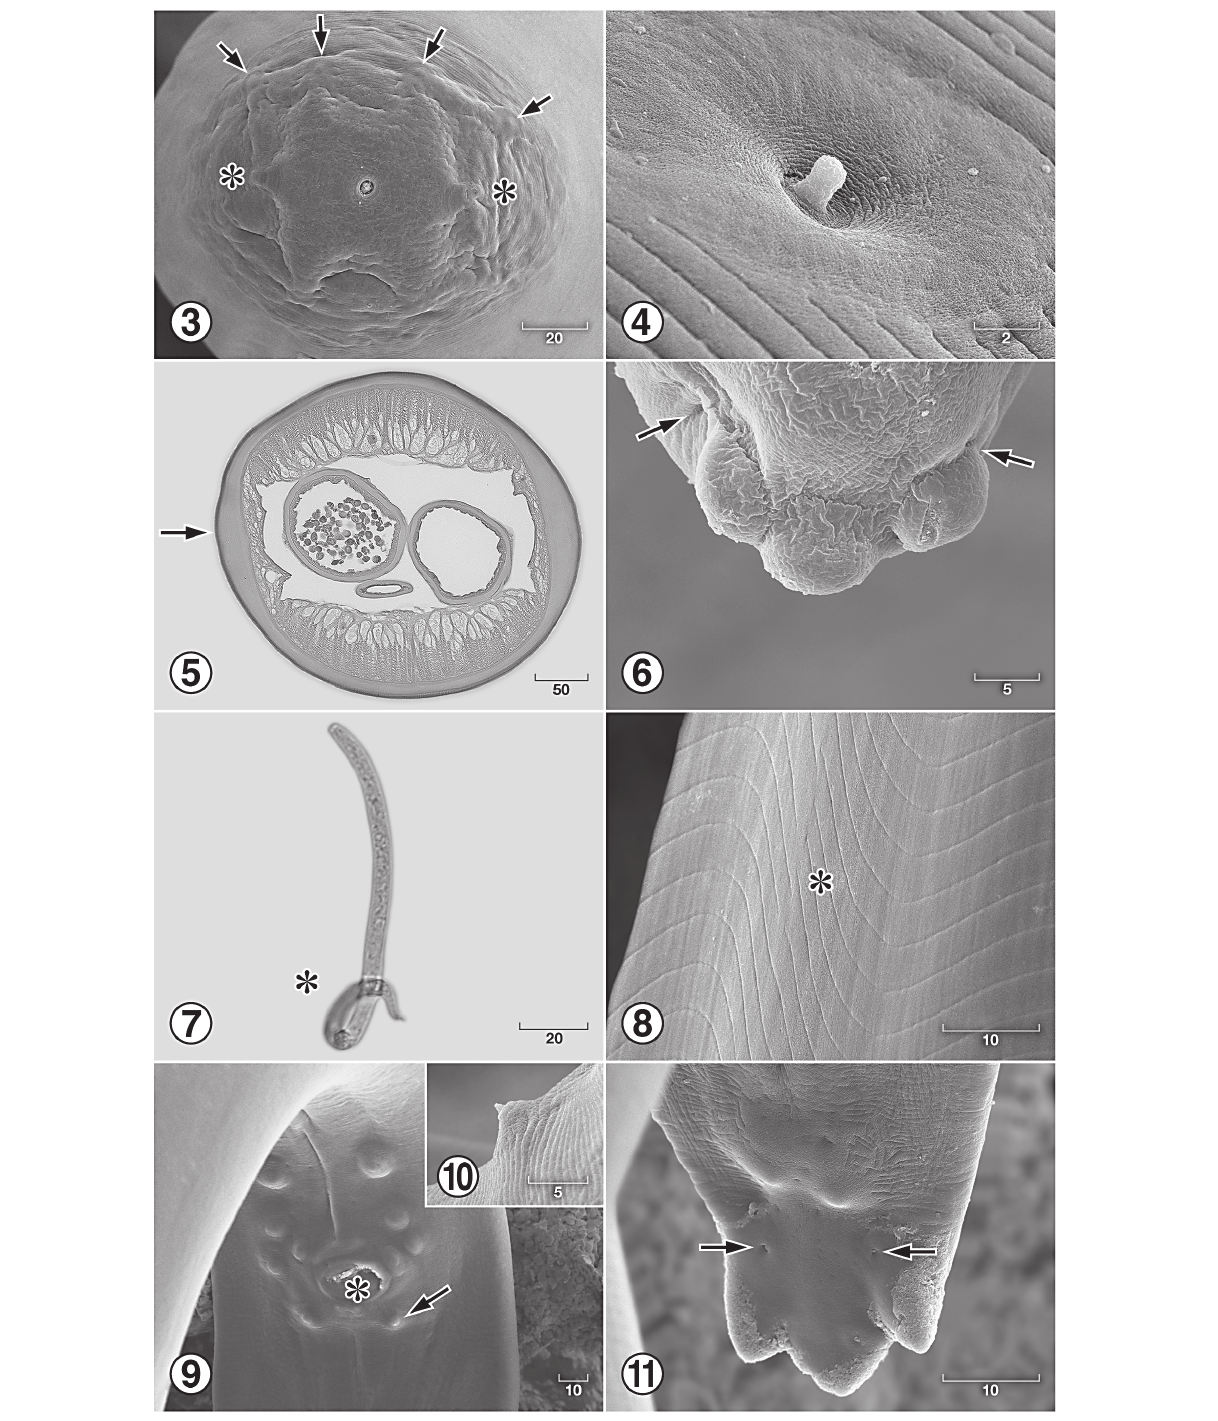
Fig. 5. – Transverse section of a female L. caprini n. sp. Lateral thickening of the cuticle (arrow). Bar, micrometers. Fig. 6. – SEM of posterior end of a female L. caprini n. sp. with phasmidial pores (arrows) and three round lappets. Bar, micrometers. Fig. 7. – Microfilaria taken from ovejector of a female L. caprini n. sp. seen by differential interference contrast microscopy. Coiled pos- terior end (*). Bar, micrometers. Fig. 8. – Oblique striations (*) in the lateral field of the midbody of a male L. caprini n. sp. Bar, micrometers. Fig. 9. – SEM of papillae around the cloaca (*) in a male L. caprini n. sp. Pair (no. 6) of papillae (arrow). Bar, micrometers. Fig. 10. – SEM of the spine of papilla (pair no. 6) in a male L. caprini n. sp. Bar, micrometers. Fig. 11. – Caudal end of a male L. caprini n. sp. with phasmidial pores (arrows) and three conical